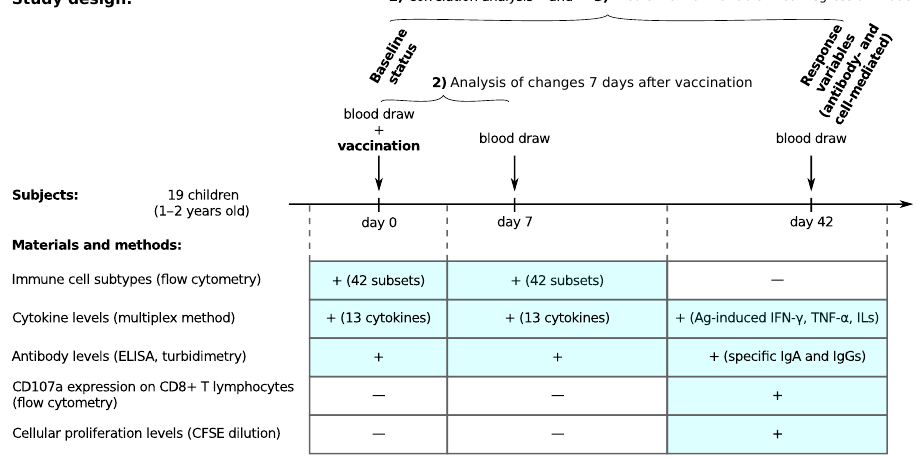
Figure 1. Study design and materials and